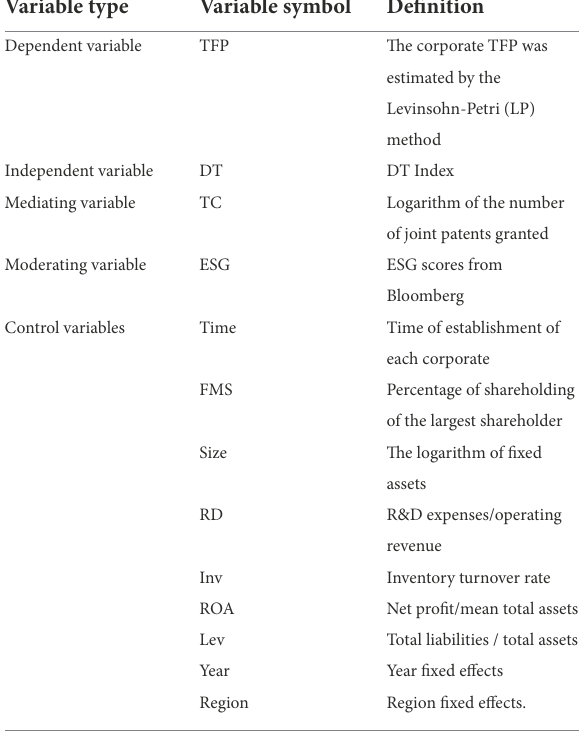
TABLE 1 The results of descriptive statistics.